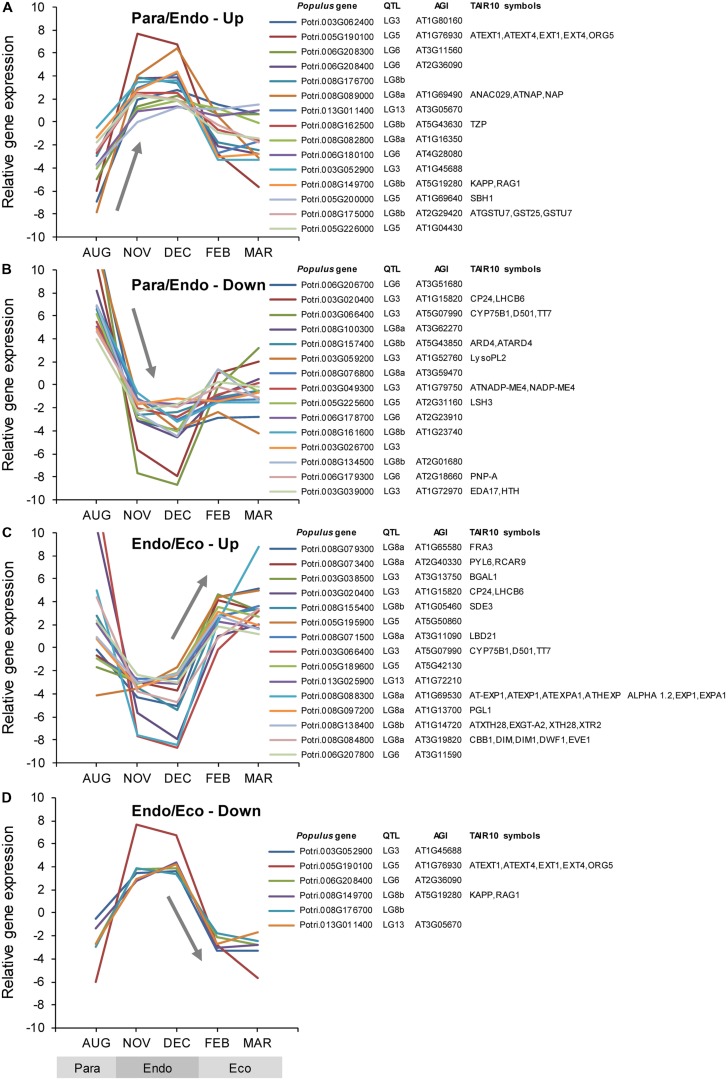
Relative expression of differentially expressed genes located near dormancy-related QTL. Genes were classified into four groups: up-regulated or down-regulated from paradormancy to endodormancy (A,B), or up-regulated or down-regulated from endodormancy to ecodormancy (C,D). Within each group, we ranked genes by FDR p-value, and then displayed the top 15 genes for each group if they had a FDR p-value < 0.05. Gene expression values are the means for each month normalized to a mean of zero and a standard deviation equal to the ANOVA RMSE from the analysis of gene expression differences among months. QTL is the QTL designation from Rohde et al. (2011b), Populus gene is the P. trichocarpa gene-locus name, and AGI and TAIR10 symbols are the Arabidopsis gene identifiers and gene symbols from the P. trichocarpa v3.0 annotations (http://www.phytozome.net/).